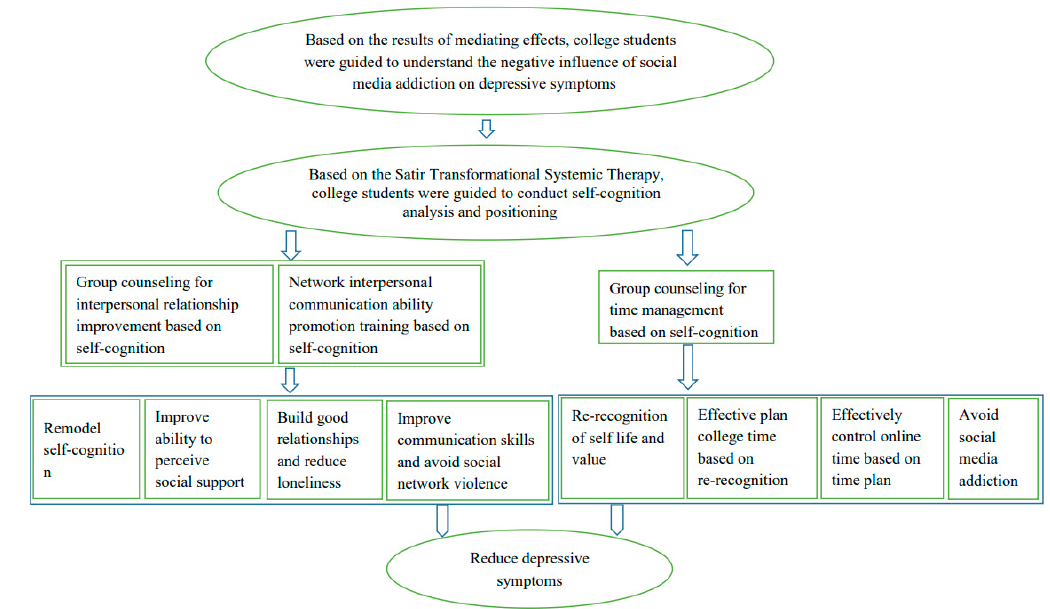
Figure 2. The theoretical model of our psychological intervention based on our findings in Study 1 and the Satir Transformational Systemic Therapy.